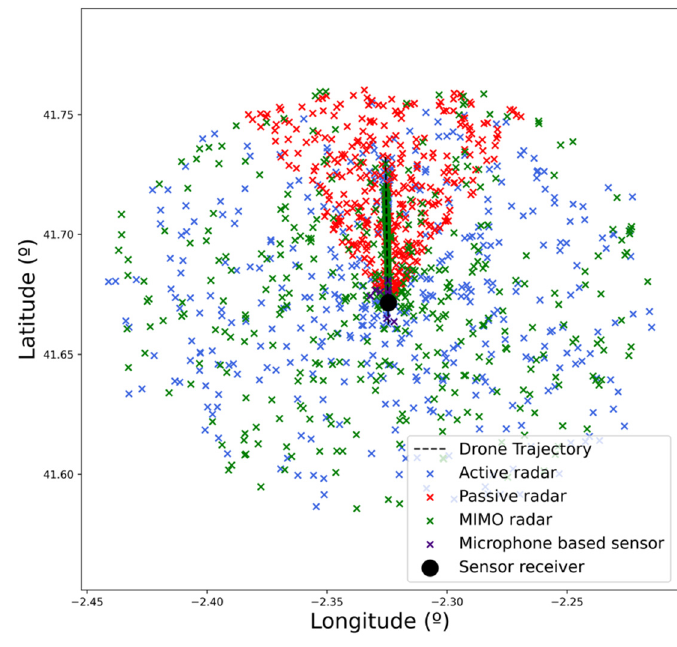
Figure 4. Plots generated by each of the sensors.